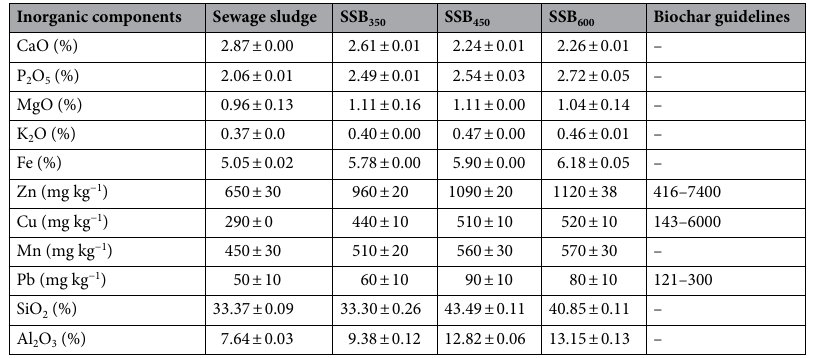
Table 3. Mean and standard deviation of the main inorganic components of the biochar as determined by fluorescence X-ray.